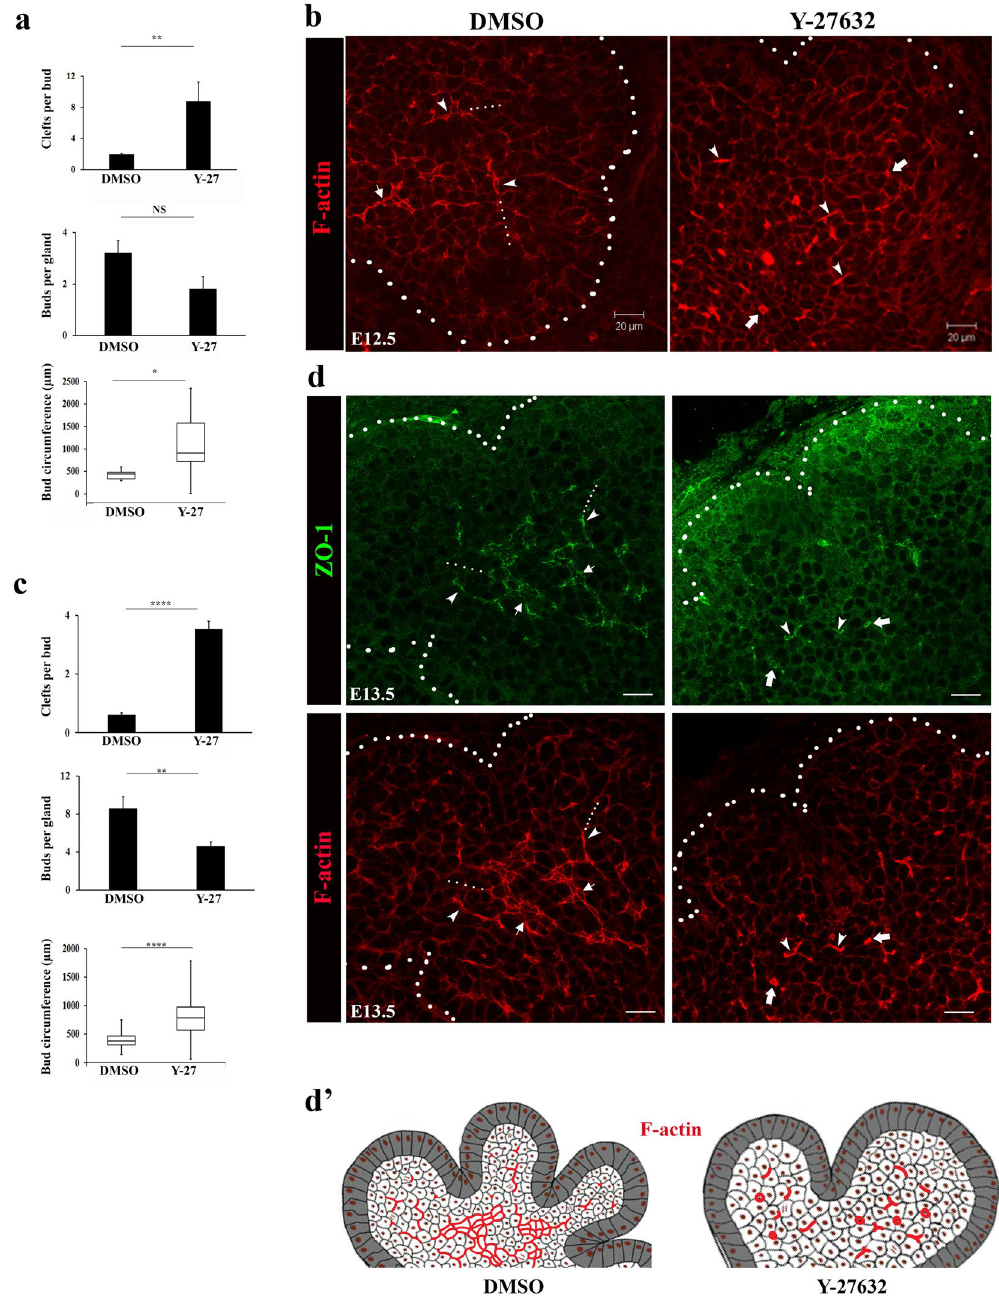
Figure 7. Inhibition of Rho kinase with Y-27632 disrupts the formation of F-actin marked ductal extensions. ( a ) Quantification of the effects of Rho kinase (ROCK) inhibition with Y-27632 on branching morphogenesis of E12.5 SMGs (n = 12) showed significant increases in the number of clefts per bud ( p ≤ 0.01) and in buds’ circumference ( p ≤ 0.05). In addition, numbers of maturing buds per gland were reduced, although these changes were not significant. ( b ) Fluorescence staining of F-actin with rhodamine-phalloidin following treatment of E12.5 SMGs with Y-27632 for 24 h revealed interrupted and condensed F-actin organization ( → ) with an accompanying loss of extending ductal paths and formation of structures resembling micro-lumens ( ➔ ). ( c ) Quantification of Y-27632 treatment of E13.5 SMGs (n = 8) for 24 h showed significant increases in the numbers of clefts ( p ≤ 0.0001), reduced numbers of buds per gland ( p ≤ 0.01) along with increased buds’ circumference ( p ≤ 0.0001). ( d ) Immunofluorescence staining of ZO-1 in Y-27632-treated E13.5 glands revealed diffuse cytoplasmic distribution of ZO-1 with a loss of its localization to the sites of asymmetry accompanied by interrupted F-actin filaments, detectable micro-lumens ( ➔ ) and loss of expansion of cells with asymmetry ( → ). ( d’ ) Schematic of changes in F-actin organization upon inhibition of ROCK with Y-27632 in E13.5 SMGs highlighting loss of F-actin-demarcated ductal paths and formation of micro-lumens. Size bars, 20